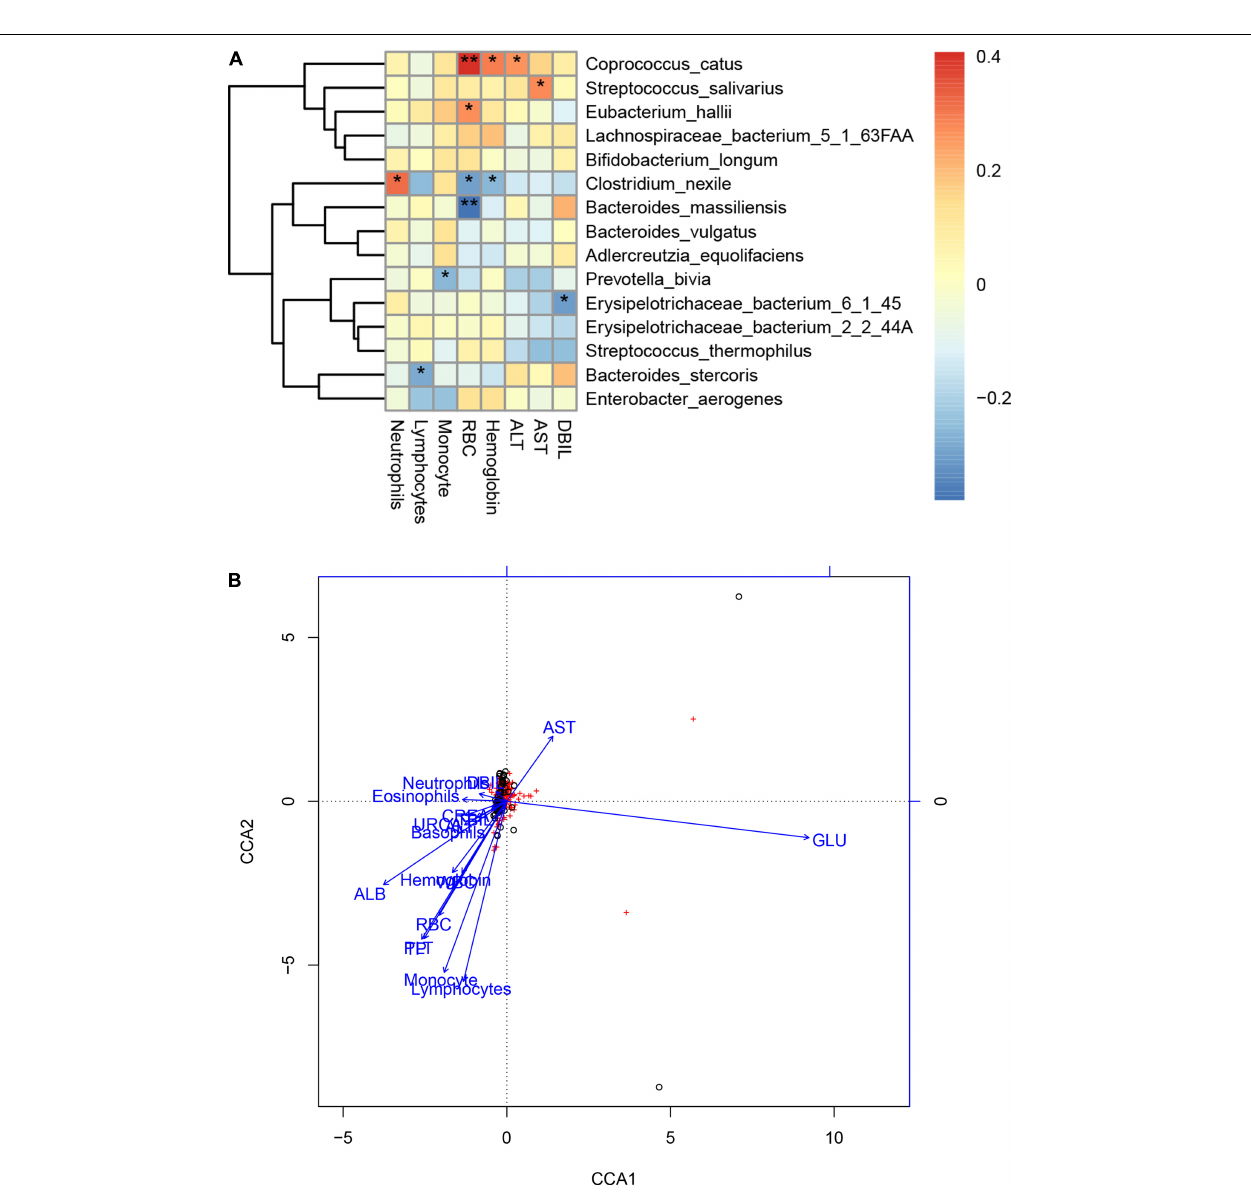
FIGURE 6 | Associations between the gut microbiome and clinical indexes of COVID-19. (A) Canonical correlation analysis (CCA) between the gut microbiome and clinical indicators of COVID-19. The heat map shows the partial Spearman’s correlation coefficients of 15 microbial species markers with eight clinical indicators of COVID-19 ( n = 47).* p < 0.05 and ** p < 0.01. (B) A network of the associations between the gut microbiota and clinical indicators of COVID-19. RBC, red blood cells; DBIL, direct bilirubin; AST, aspartate aminotransferase; ALT, alanine aminotransferase; CREA, creatinine; URCA, uric acid; ND, no detection; –, no calculation or no